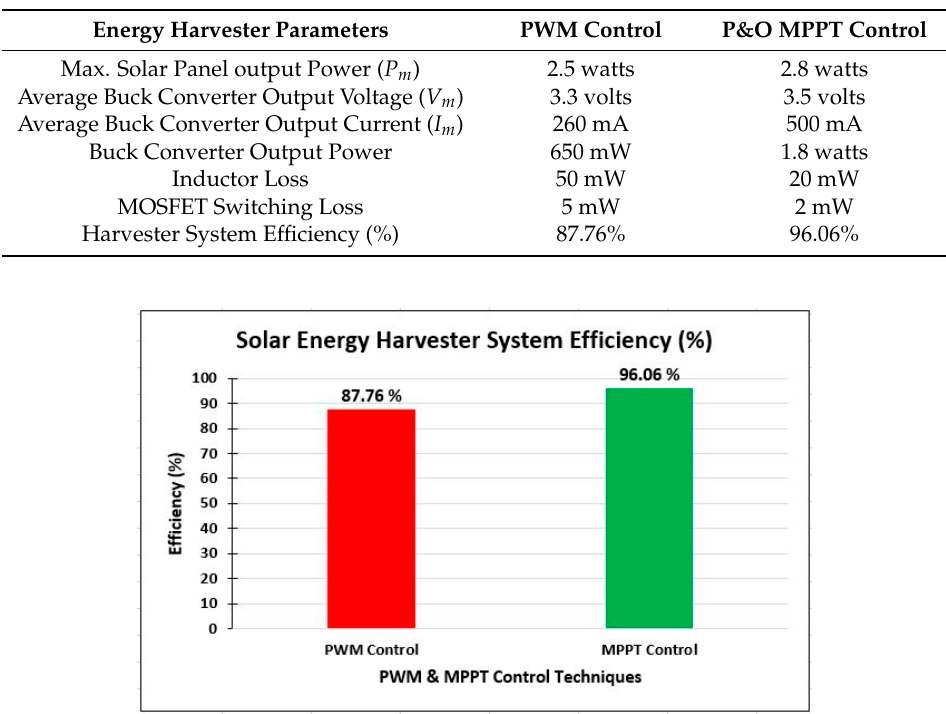
Figure 13. Comparison of PWM and P&O MPPT Harvesting System Efficiency (cid:3435)𝜂 (cid:3046)(cid:3052)(cid:3046) (cid:3439) .